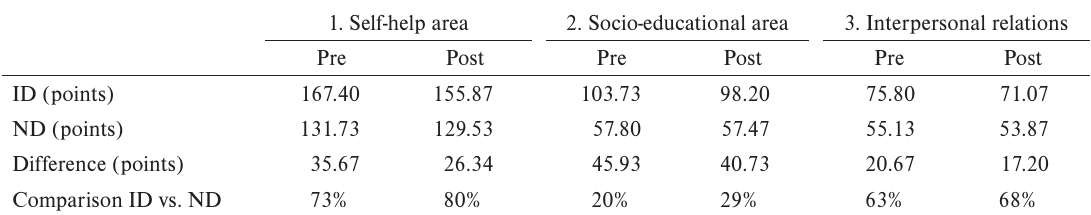
Comparison of the average test scores of social skills 1. Self-help area 2. Socio-educational area 3. Interpersonal